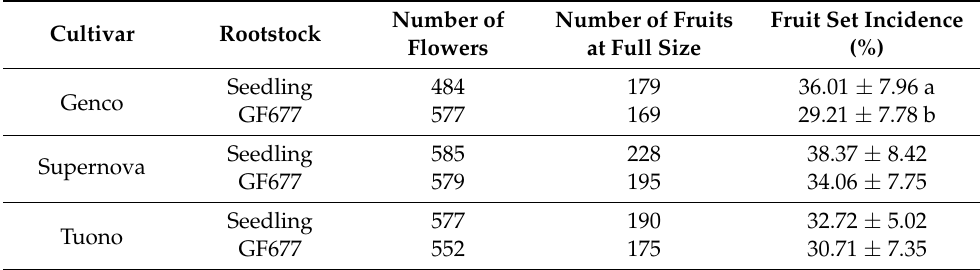
Table 4. Incidence of fruit set in cultivars ‘Genco’, ‘Supernova’ and ‘Tuono’ grafted on clonal rootstock ‘GF677’ and seedling rootstocks (trial A), calculated at the end of April 2021. Data are reported as mean ± standard deviation. Different lowercase letters on the columns indicate significant differences between rootstocks (Fisher’s test p <